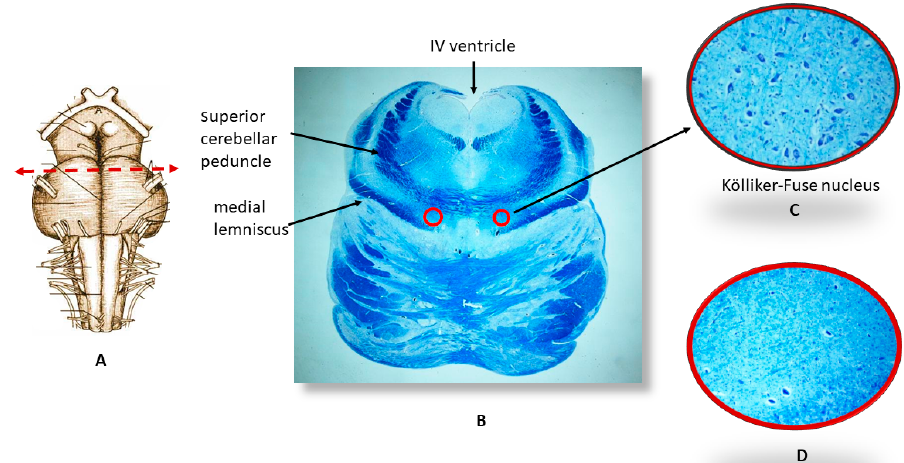
Figure 2. An image series related to the Kölliker-Fuse nucleus (KFN). ( A ) Ventral brainstem image indicating the best level for optimizing the sampling of the KFN; ( B ) Histological section cut at the previously-mentioned level. The circles show the bilateral localization of the KFN, represented at higher magnification in ( C ); At this magnification, a considerable number of large neurons can be seen which are intermixed with smaller cells (interneurons and astrocytes); ( D ) Hypoplasia of the KFN observed in a newborn who died 24 h after birth. ( B ) Klüver Barrera staining, magnification: 0.5×; ( C , D ) Klüver–Barrera staining, magnification: 20×.